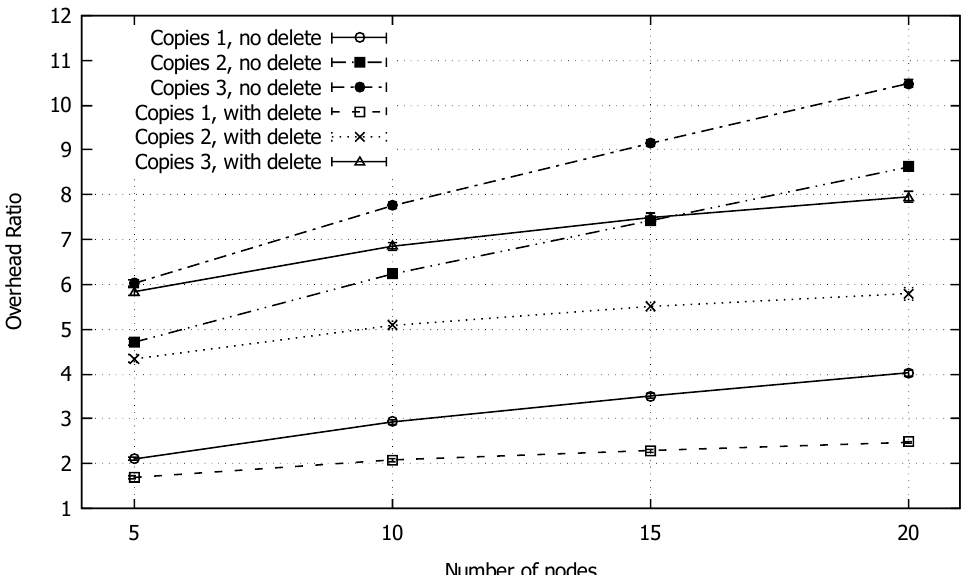
Figure 8. Average overhead ratio of GeoSaW with different parameters combinations when varying the number of nodes.